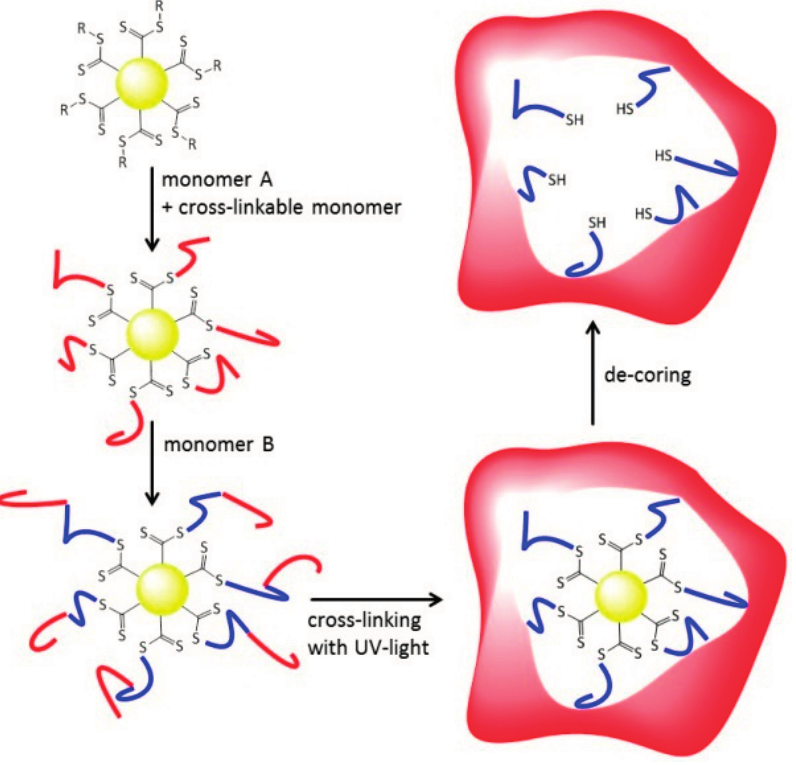
Figure 2. Multi-step process for synthesizing nano-containers via Z-RAFT star polymerization, as presented in this